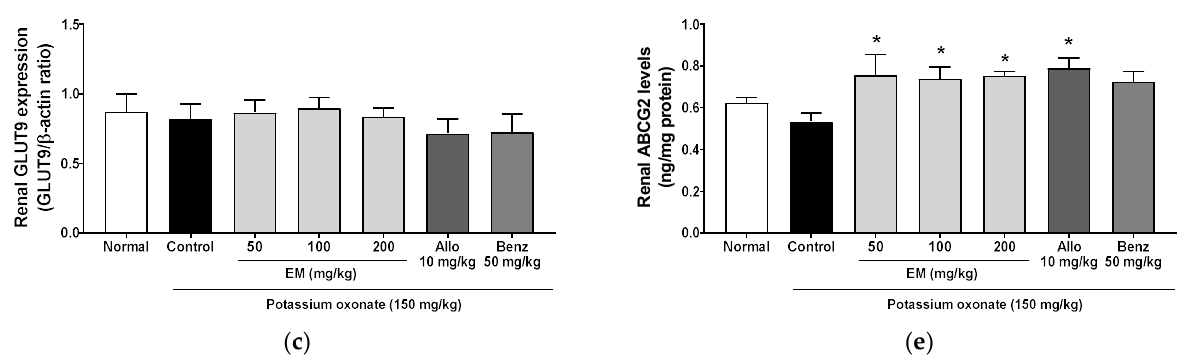
Figure 5. The effects of EM on the expression of urate transporters in rats with PO-induced hyperuricemia. ( a ) Renal protein expression levels of URAT1, GLUT9, and OAT1 urate transporters by Western blot analysis. Protein expression ratio of ( b ) URAT1, ( c ) GLUT9, and ( d ) OAT1. ( e ) ABCG2 levels by ELISA; (n = 5 per group). Allo, allopurinol; Benz, benzbromarone. ## p < 0.01 vs. the normal (N) group; * p < 0.05 and *** p < 0.001 vs. the PO group.